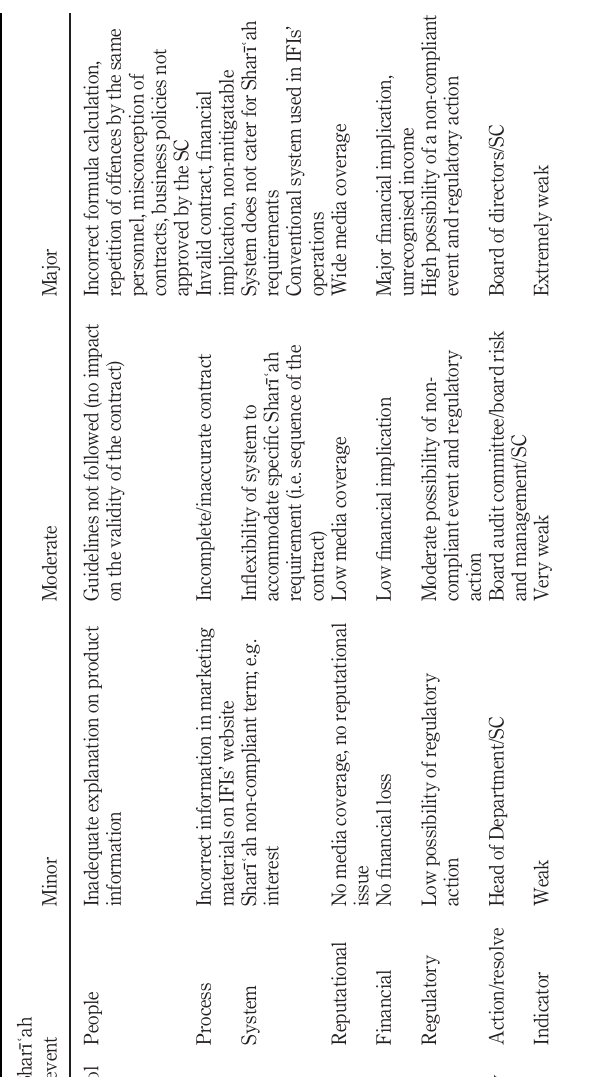
Table 3. Internal control system assessment matrix for Shar ī ʿ ah-